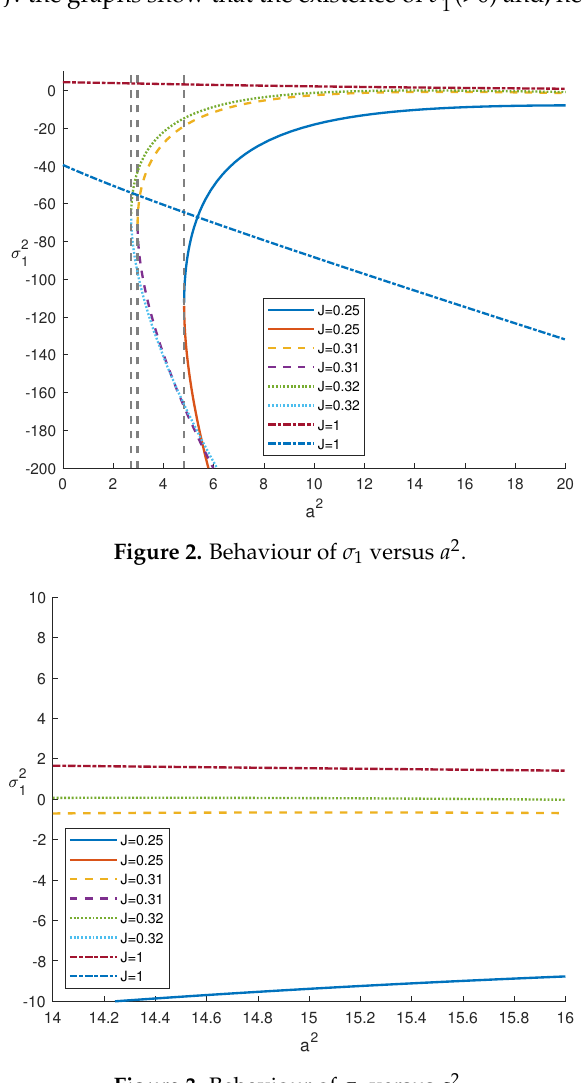
Figure 3. Behaviour of σ 1 versus a 2